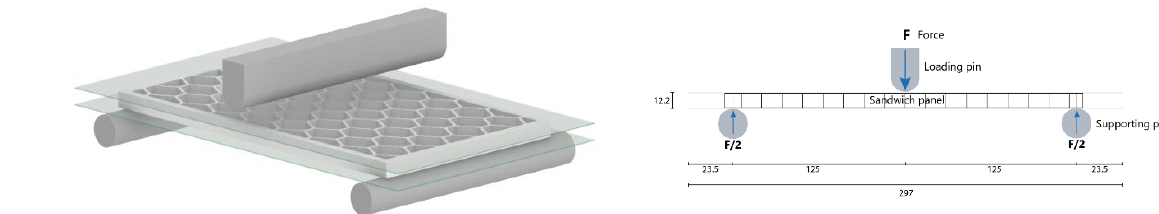
Fig. 9 Principle and setup for the 3 point bending